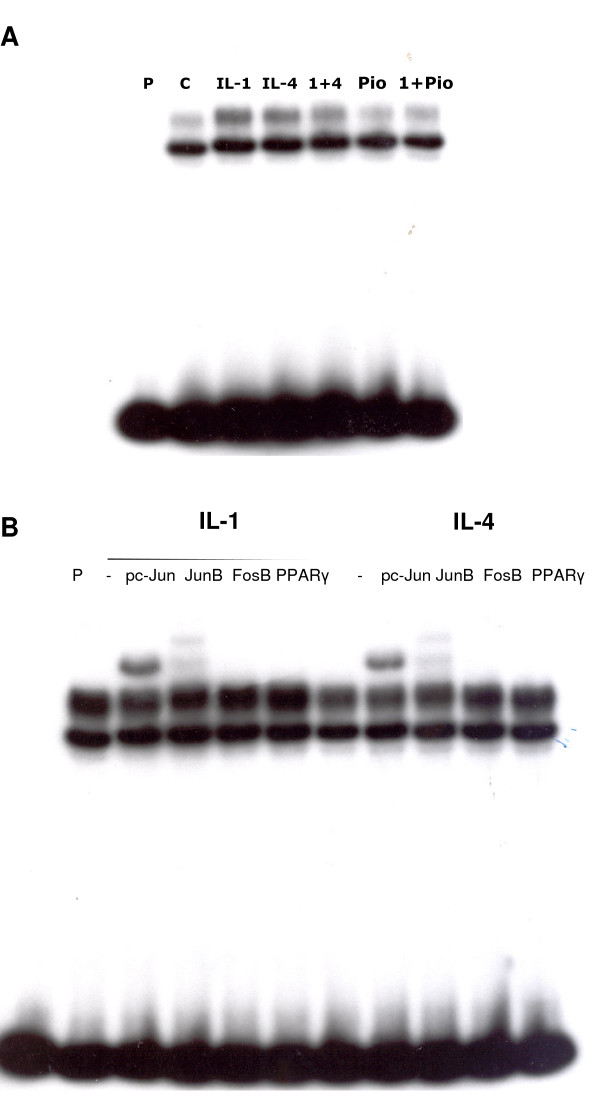
There is no qualitative change in binding to the PPRE/AP-1 site in the presence of IL-4 or pioglitazone. A) HGF were incubated in the presence of IL-1 (10 ng/ml), IL-4 (10 ng/ml), and/or pioglitazone (1 μM) as indicated for 1 hour. Five μg nuclear extract were incubated with a 32P-labeled oligodeoxynucleotide probe containing the putative composite PPRE/AP-1 site from the MMP-3 promoter. P = probe alone, no extract; C = control, no cytokines. B) HFG were incubated in the presence of IL-1 (10 ng/ml) or IL-4 (10 ng/ml for 1 hour. Five μg nuclear extract were incubated with the PPRE/AP-1 site probe in the presence of the indicated antibodies. P = probe, no extract.